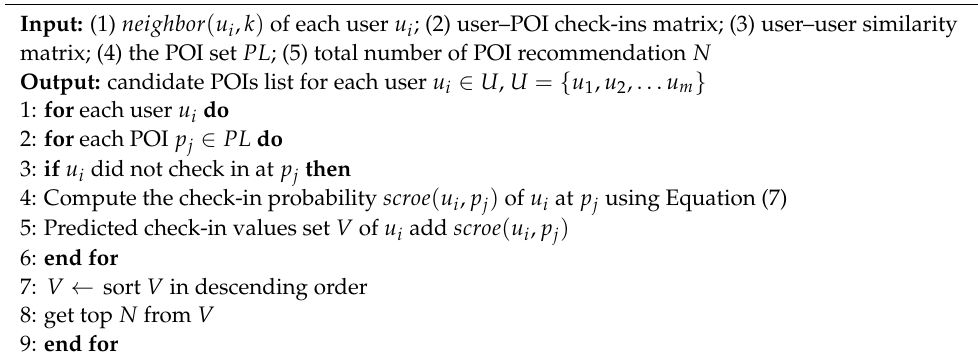
Algorithm 3. A unified POI recommendation method using the memory effect and POI stickiness